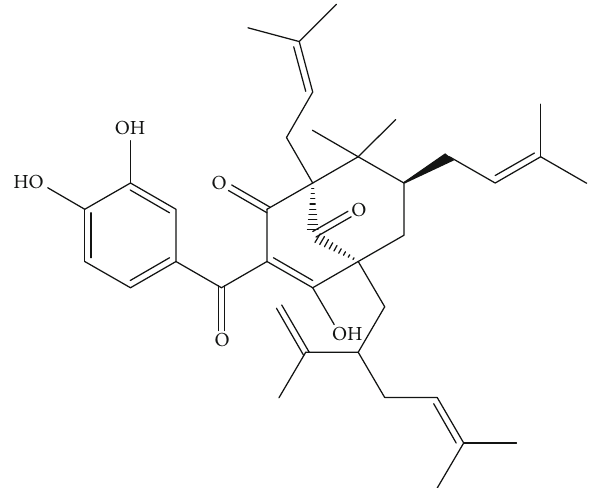
Figure 1: Chemical structure of guttiferone